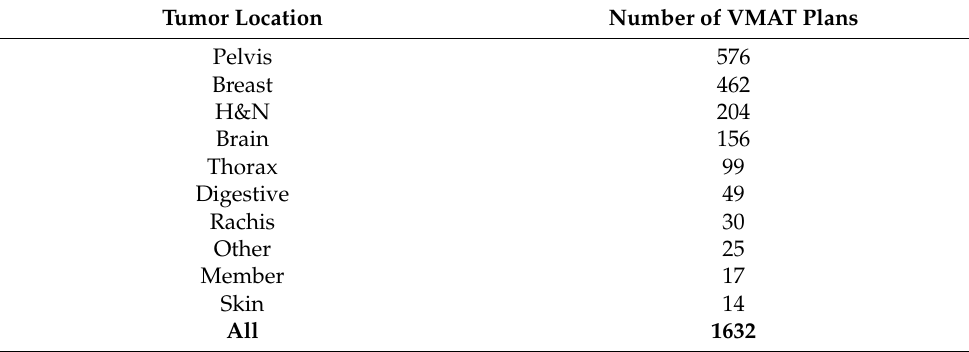
Table 1. Description of the patient cohort and tumor location.